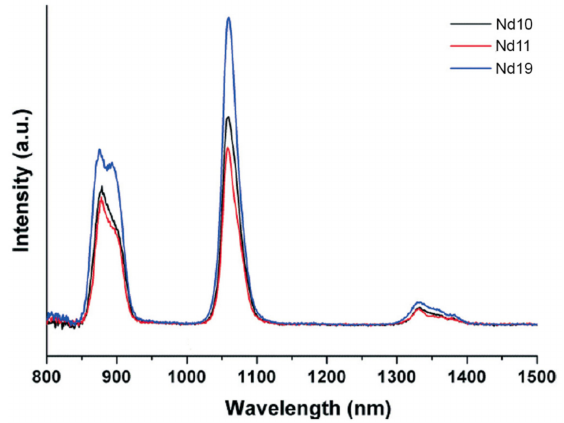
Figure 10. Near Infrared (NIR) luminescence spectra of the Nd 10 , Nd 11 , and Nd 19 clusters supported by p -tert-butylsulfonylcalix[4]arene in the solid state at room temperature. Reproduced by permission of The Royal Society of Chemistry from